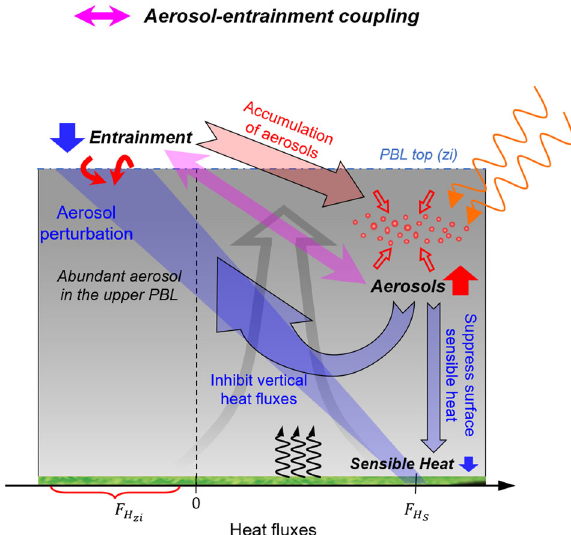
Fig. 5 A schematic diagram describing the aerosol-entrainment coupling. The background grey arrow sketches the vertical transport of humidity, aerosols, and heat fl uxes. Orange, curved arrows represent solar radiation. The blue dash-dotted line represents the position of the PBL top ( zi ). Black, curved arrows indicate sensible heat fl uxes. Red, curved arrows indicate entrain- and F H represent surface SH fl uxes and the ment at the PBL top. F H S zi entrainment heat fl uxes, respectively. The blue arrows represent the suppression effects of aerosols on the surface sensible heat and vertical heat fl uxes. The blue, shaded area indicates the perturbation in heat fl uxes induced by aerosols. Red arrows represent the accumulation of aerosols under the weak entrainment condition. Due to these interactions, the entrainment and aerosols are coupled here (marked as the pink double